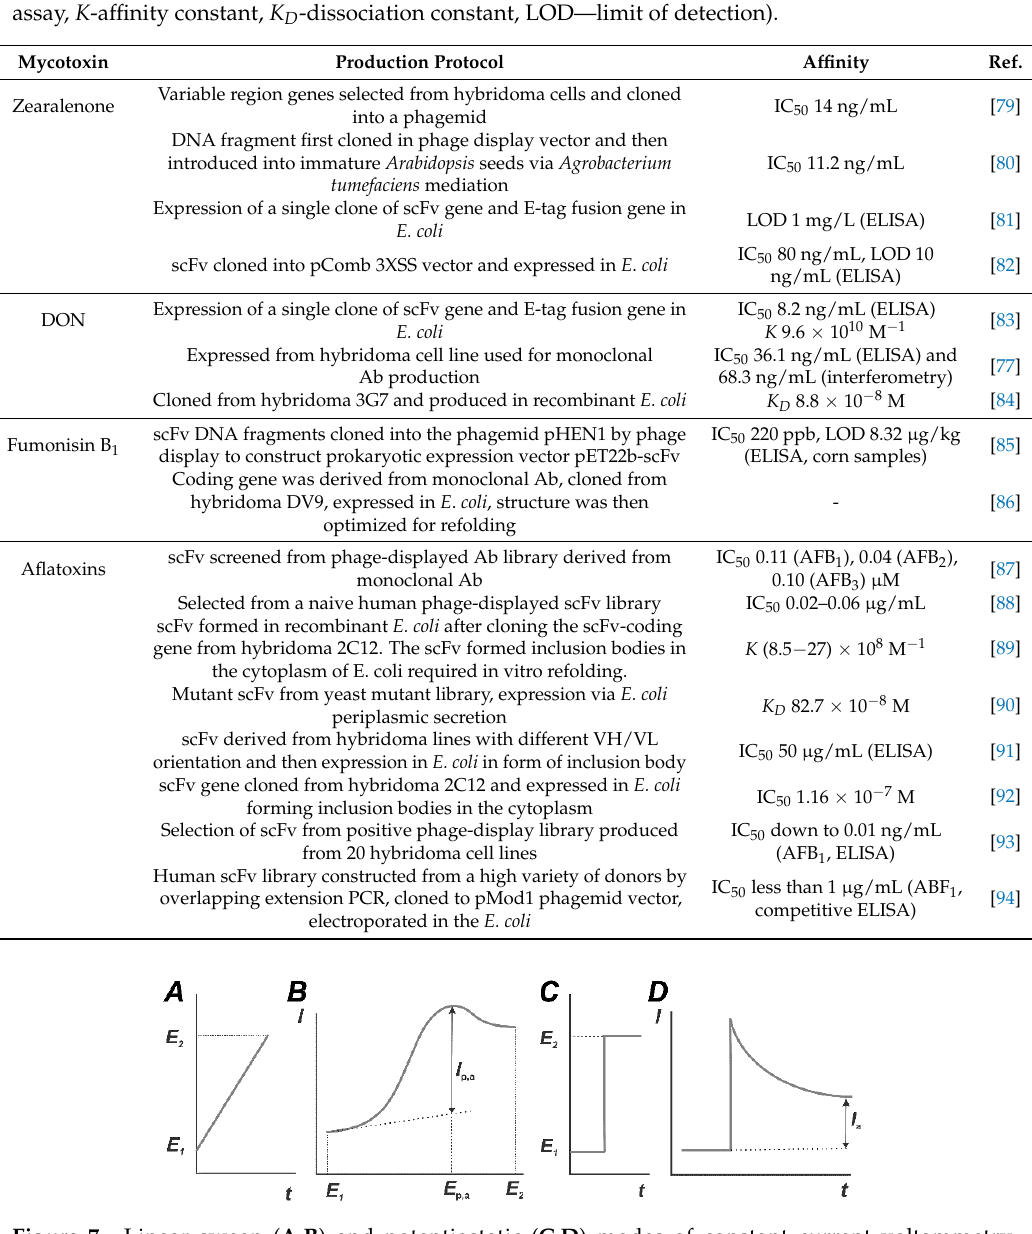
Figure 7. Linear sweep ( A , B ) and potentiostatic ( C , D ) modes of constant current voltammetry. Temporal changes in the working potential ( A , C ) and voltammetric curves ( B , D ).